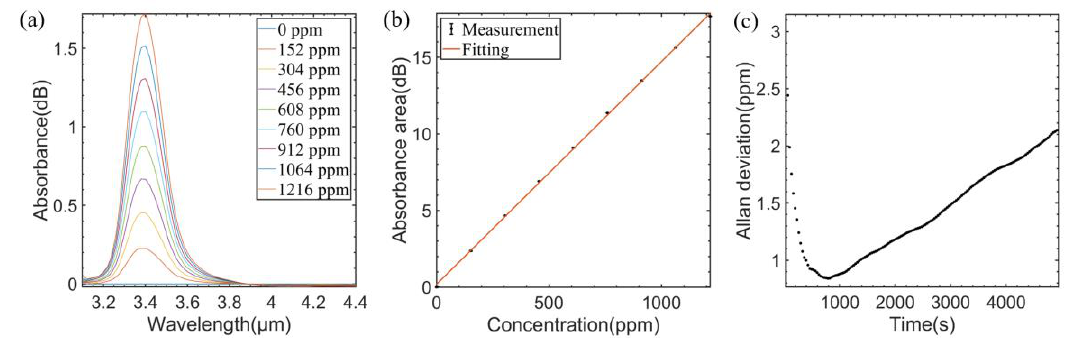
Figure 7. ( a ) Measured absorption spectra of different C 2 H 6 concentrations. ( b ) Experimental data and fitting curve of C 2 H 6 concentration versus absorbance area. ( c ) Allan variance analysis of the sensor for C 2 H 6 .